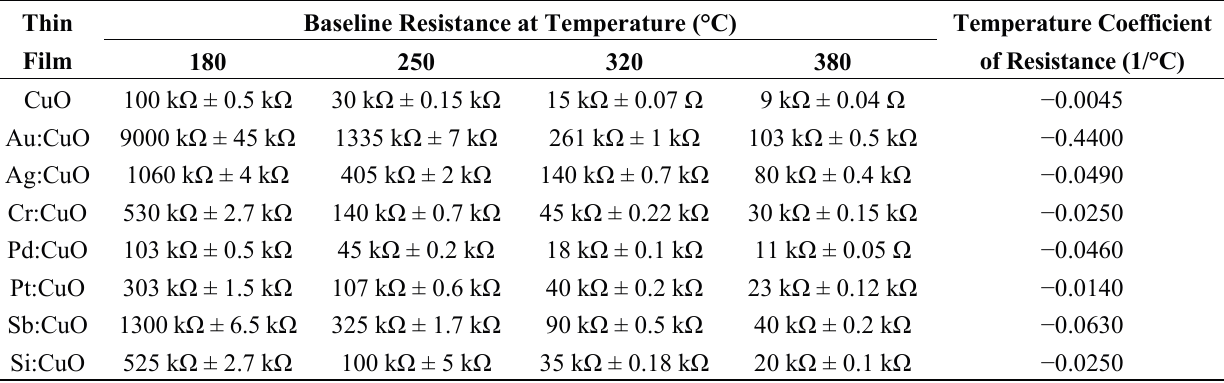
Table 2. The baseline resistances in air at various temperatures for 50-nm thin films deposited at 100 °C and annealed at 500 °C for 4 h in dry